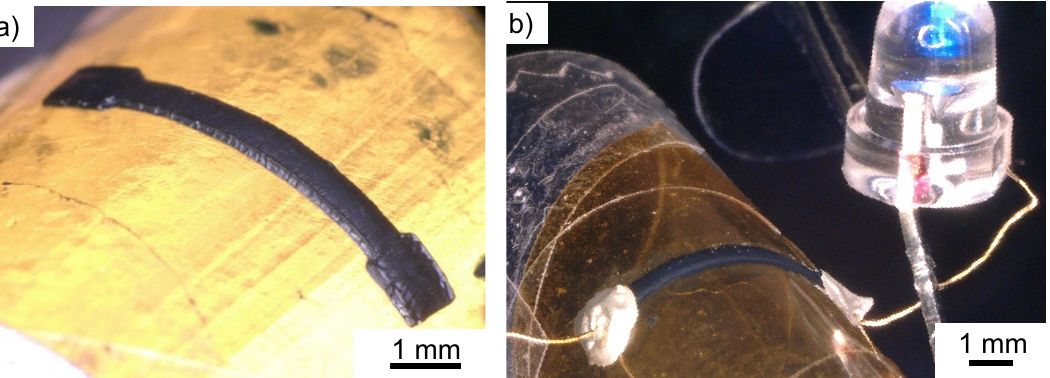
Figure 11. Example of fabricated flexible wiring on PI-PEI-SR399. ( a ) Flexible wiring on PI-PEI-SR399. ( b ) Blue LED and power source connect fabricated flexible wiring on PI-PEI-SR399.